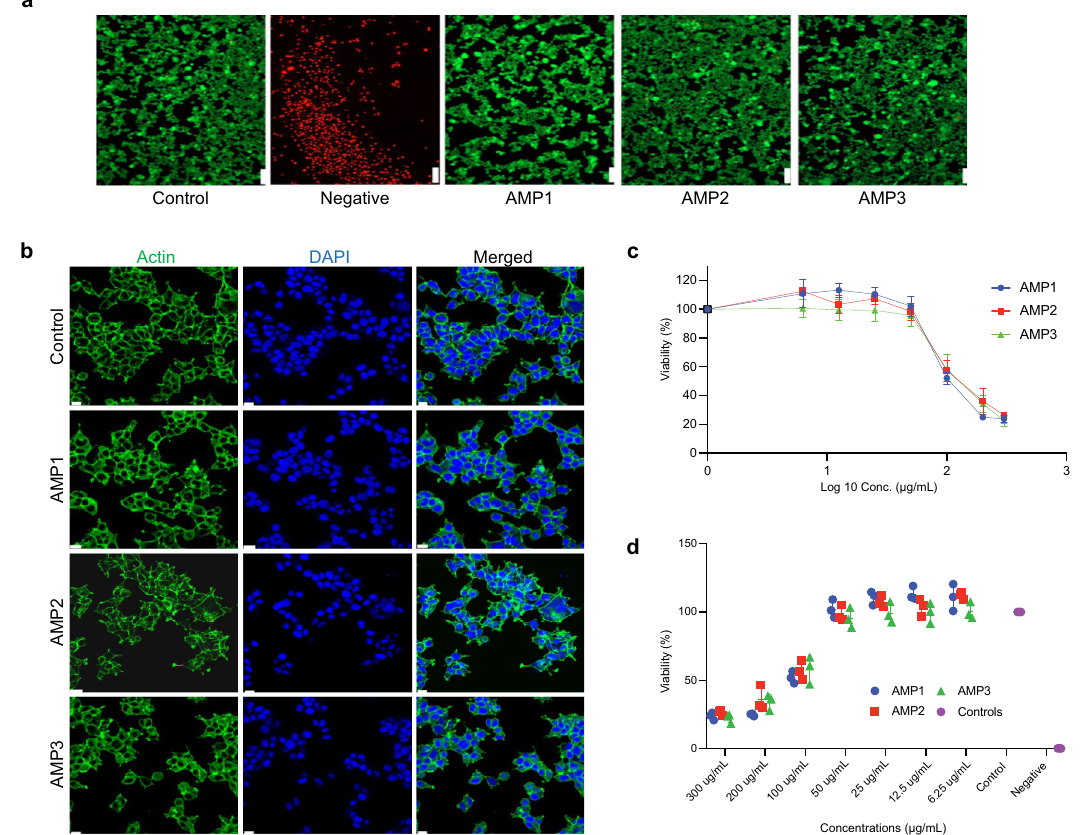
d bargraphillustration ofmetabolic index of both peptide treated (300,200, 100, 50, 25,12.5,6.25 μ g/mL)and untreatedcells asmeasured byestimatingthe cellular ATP levels using luciferase-based CellTiter-Glo® reagent. Cell viability was quanti- fi ed as the ratio of ATP levels-dependent luminescence in treated / untreated cells expressed aspercentage.Untreated:cellsinatissuecultureplatetreatedwithPBS; Negative control: cells treated with 1% [v/v] Triton-X 100 (± SD, n =3 independent biological replicates). Source data are provided as a Source Data fi